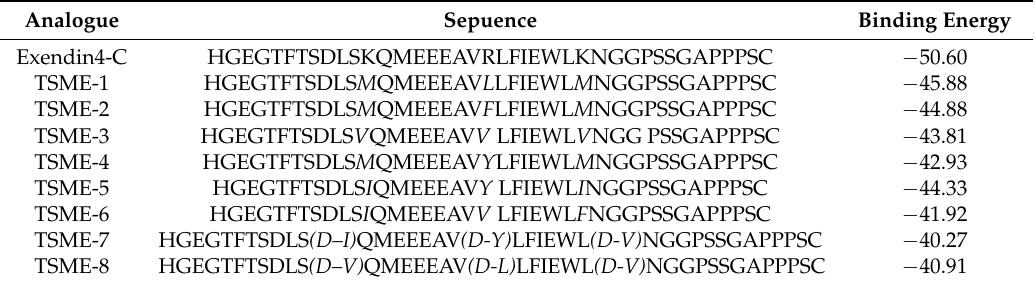
Table 3. The binding energy of the analogs calculated following molecular dynamics simulations. A lower value predicts a stable binding structure between the ligand and receptor along with a higher affinity. The italic letter means mutated amino acid